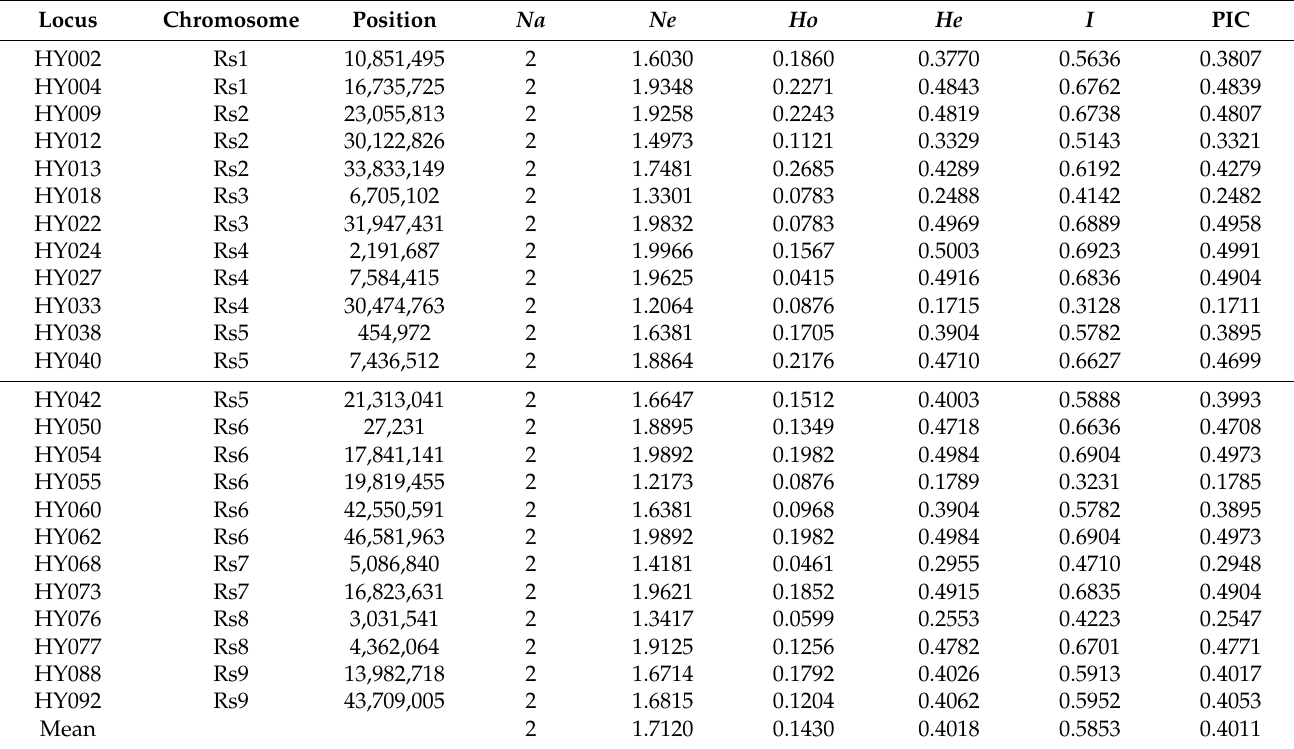
Table 1. Genetic diversity analysis of 217 radish accessions based on 24 SV